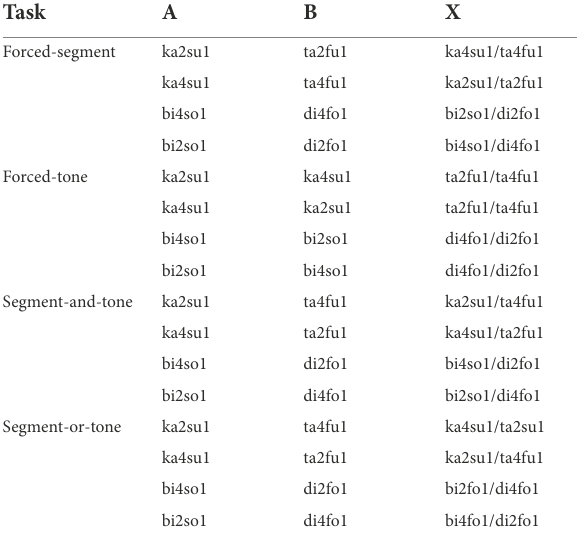
TABLE 2 Arrangement of stimuli in ABX